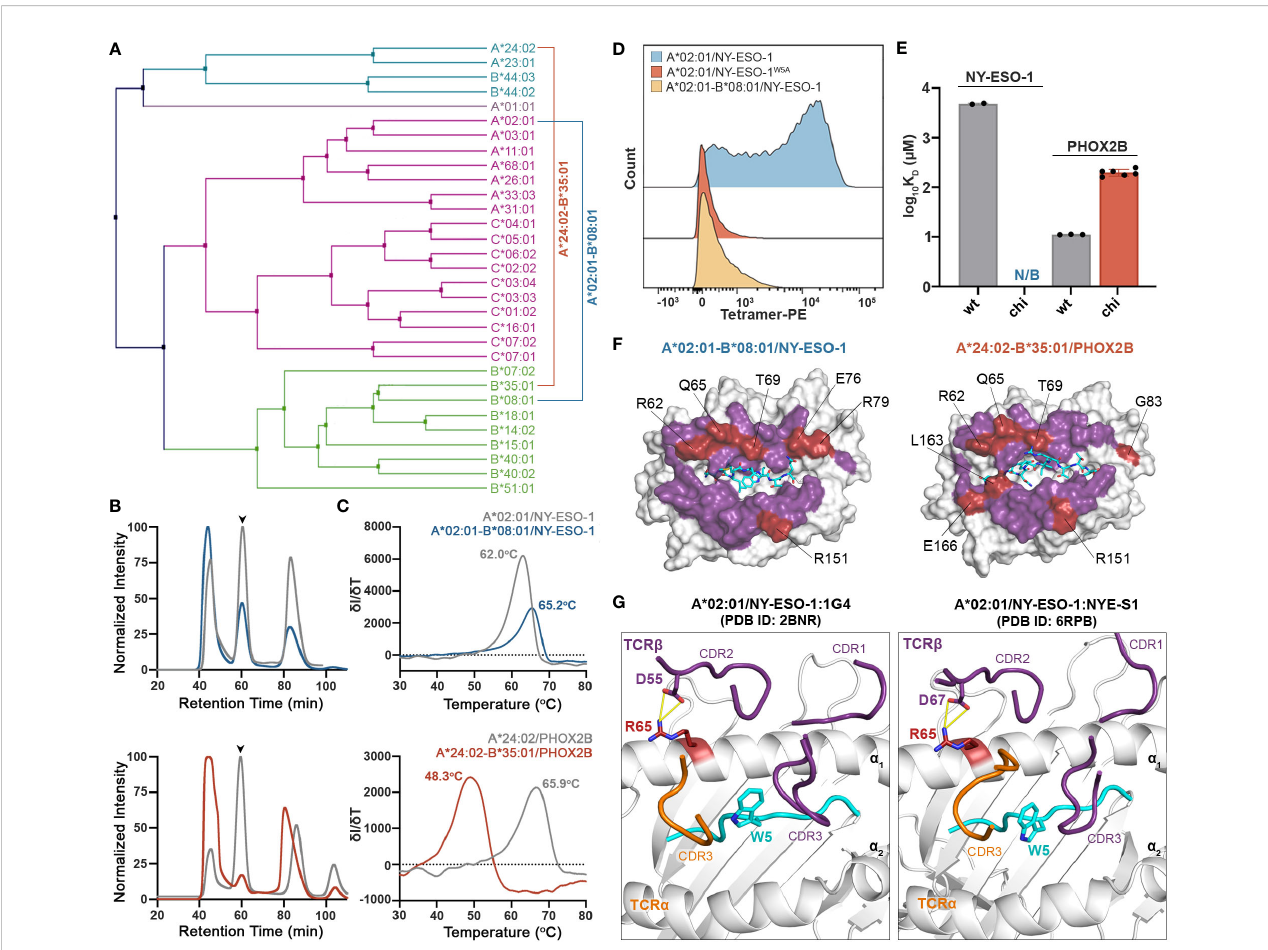
FIGURE 5 Application of chimeric HLAs as probes for assessing peptide-centric interactions with immune receptors for targeted therapy. (A) Phylogenetic analysis of a divergent set of common HLA allotypes using the TCR contacting residues to de fi ne sequence similarity. (B) SEC traces of recombinant HLA- A*02:01/NY-ESO-1, A*02:01-B*08:01/NY-ESO-1, A*24:02/PHOX2B, and A*24:02-B*35:01/PHOX2B molecules. The protein peaks are indicated by the arrows. (C) Melting temperatures (T m , °C) of the pMHC alleles in (B) determined by DSF experiments. Data are mean ± SD obtained for n = 3 technical replicates. (D) Staining of 1G4-transduced primary CD8+ T cells with PE-conjugated tetramers of A*02:01 presenting the wild-type NY-ESO-1 or the mutated NY-ESO-1 W5A peptides, and the chimeric A*02:01-B*08:01/NY-ESO-1 complex. Staining was observed only in the case of A*02:01/NY-ESO-1, suggesting positive recognition by the TCR, whereas in the case of the negative control and the chimeric pMHC the interactions are disrupted. (E) Comparison of the SPR determined K D values for NYE-S1 and 10LH interacting with HLA-A*02:01 and A*24:02 wild-type and chimeric molecules presenting NY-ESO-1 and PHOX2B peptides, respectively. Data are mean ± SD for n = 2 (NYE-S1) or n = 3 (10LH) technical replicates. K D , equilibrium constant; N/B, no binding. (F) Surface structure of the Rosetta model of HLA-A*02:01-B*08:01/NY-ESO-1 and A*24:02-B*35:03/PHOX2B chimeras, where all TCR-contact residues are highlighted (purple and red). The wild-type B*08:01 or B*35:01 residues are shown in red. (G) Structural comparison of the HLA-A*02:01/NY-ESO-1 complex bound by the TCRs 1G4 (PDB ID: 2BNR) and NYE-S1 (PDB ID: 6RPB). The HLA-A*02:01, the NY-ESO-1 peptide, and the TCR- a and - b chains are colored in white, cyan, orange, and purple, respectively. The identi fi ed Arg65 is represented as a single stick (in red) and its interactions with TCR- b chain are in